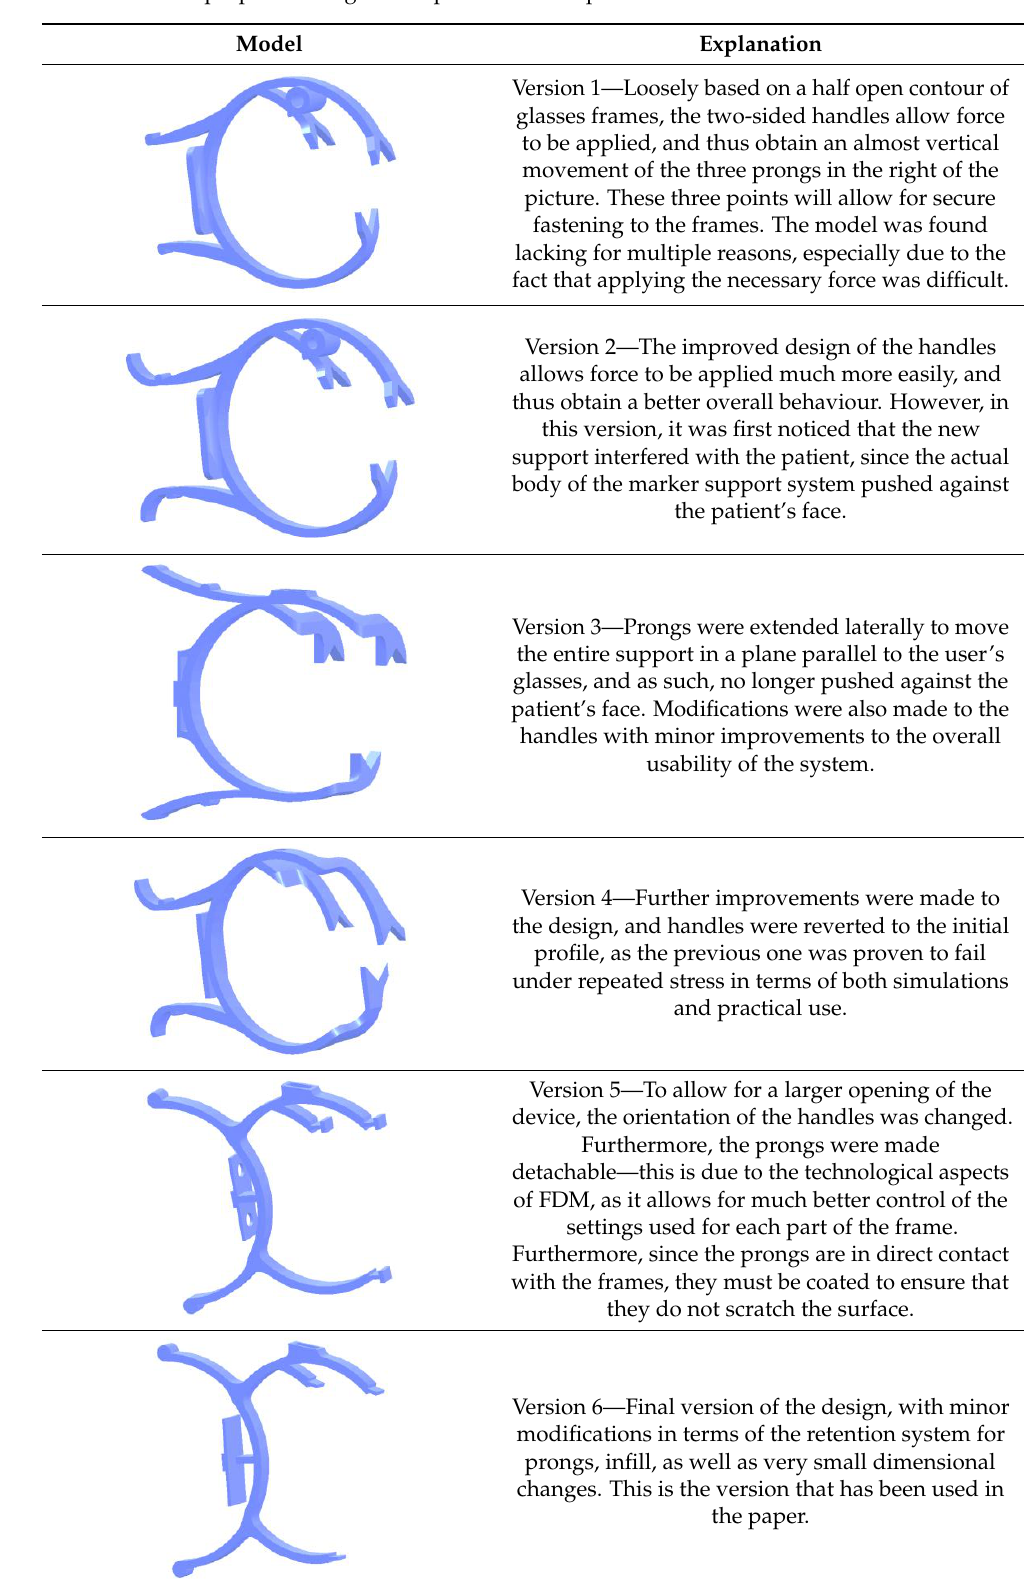
Table 1. Several proposed designed shapes for the compliant mechanism.